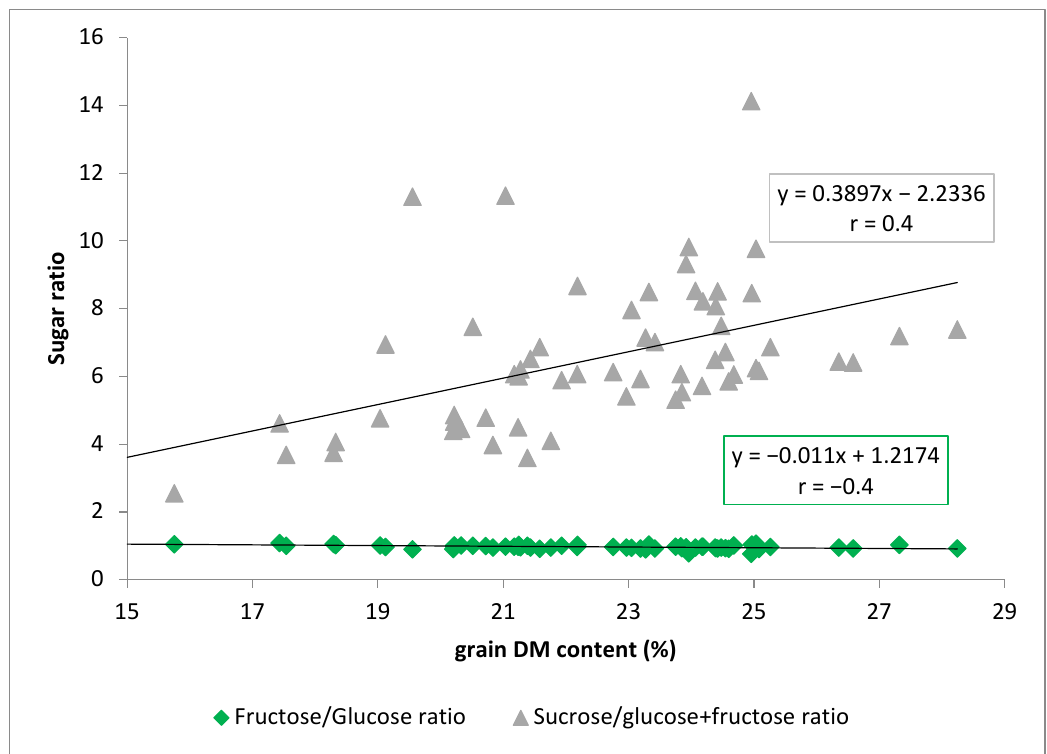
Figure 4. Regression curve between grain dry matter (DM) content and sugar ratio (% of fresh matter).